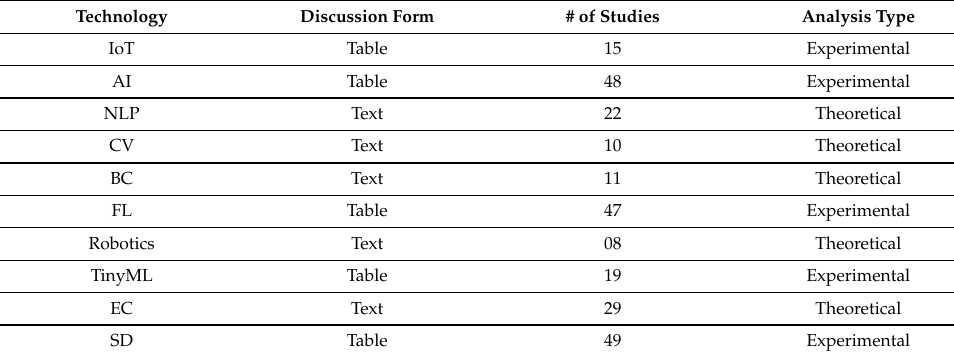
Table 7. Details of the analysis presented for each identified